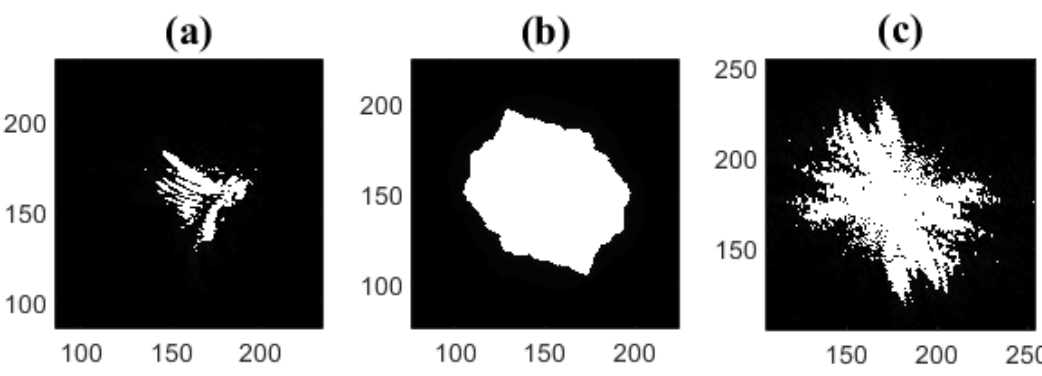
Figure 7. One of the two symmetric spread spots of Figure 6b ( a ), its binarized 2D-autocorrelation ( b ) and the central spread spot of Figure 6b for comparison ( c ). Axes units are in pixels.